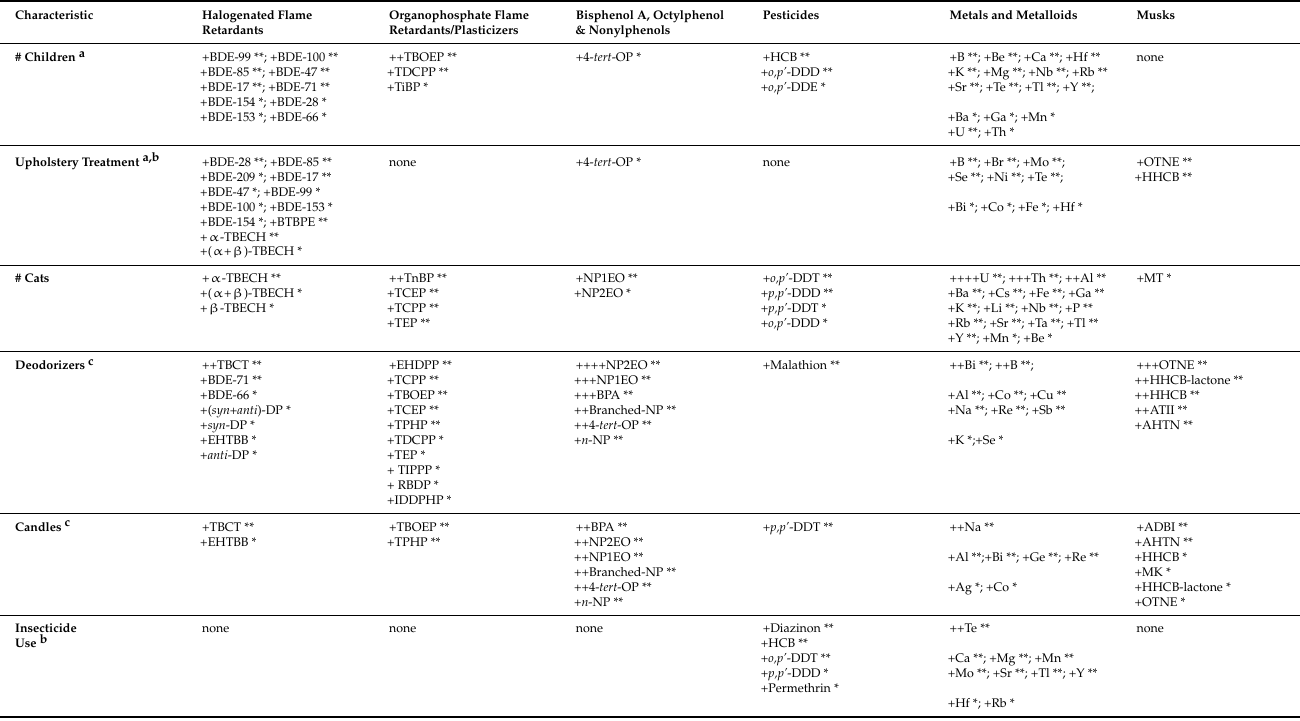
Table 7. Relationships between contaminant concentrations in dust and characteristics related to consumer products identified using Spearman rank correlation